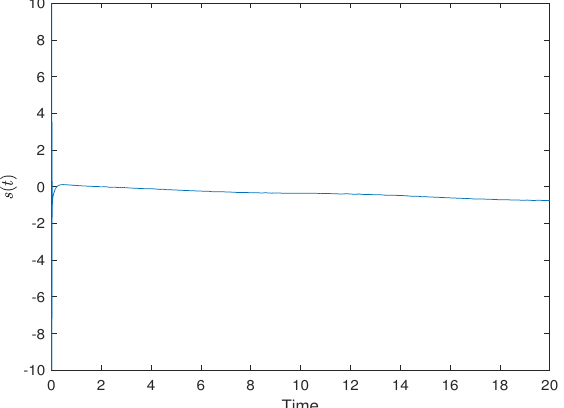
Figure 4. The convergence of sliding variable s ( t )